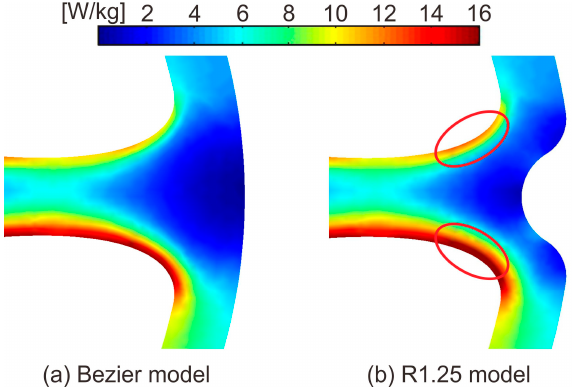
Figure 14. Enlarged view of a region of the back yoke in core loss distribution of ( a ) the Bezier model and ( b ) R1.25 model.